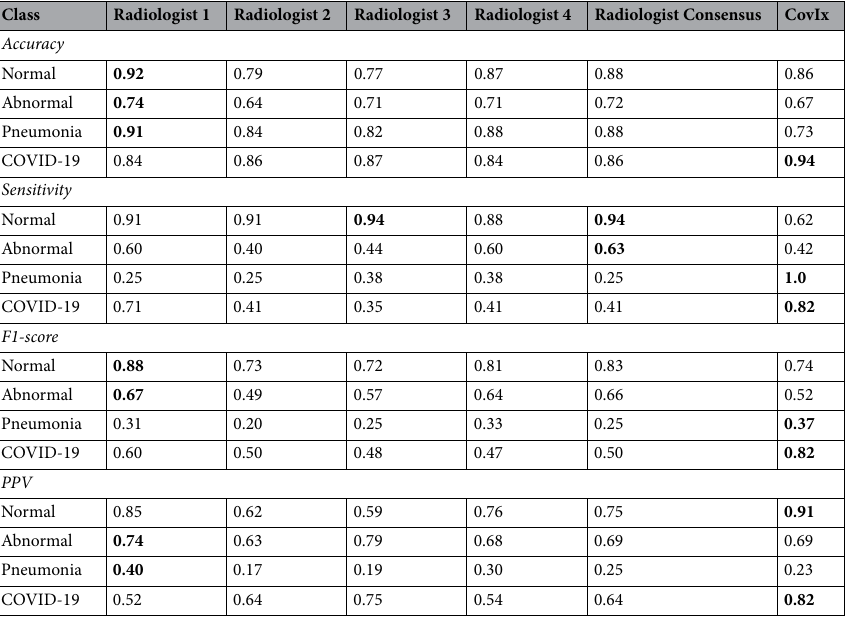
Table 3. Comparison of model performance with Radiologist labels. Top results are shown in